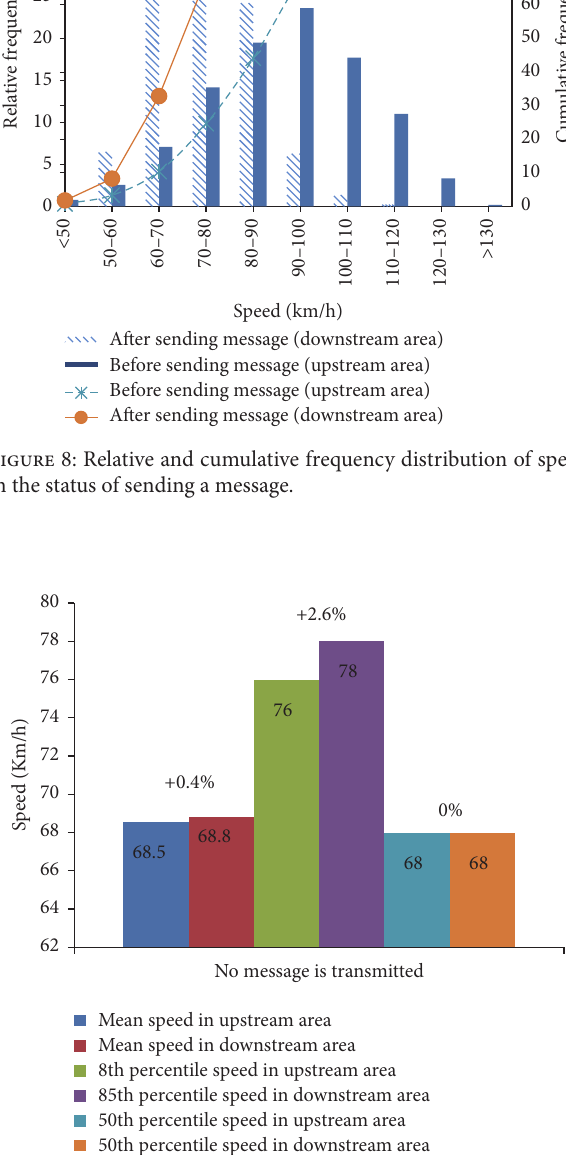
Figure 9: Changes in mean and 50th percentile and 85th percentile speed when no messages are transmitted.